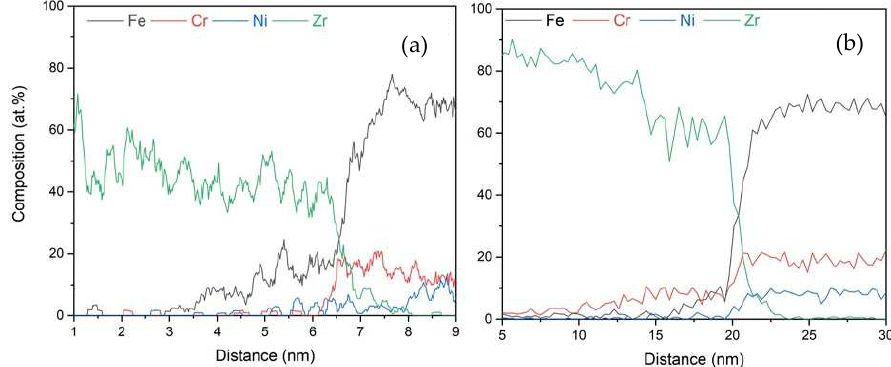
Figure 6. APT concentration profiles obtained for the Zr + -etched and Zr-coated sample performed ( a ) in electrical mode on IRMA GPM platform and ( b ) in laser mode on CEA platform.